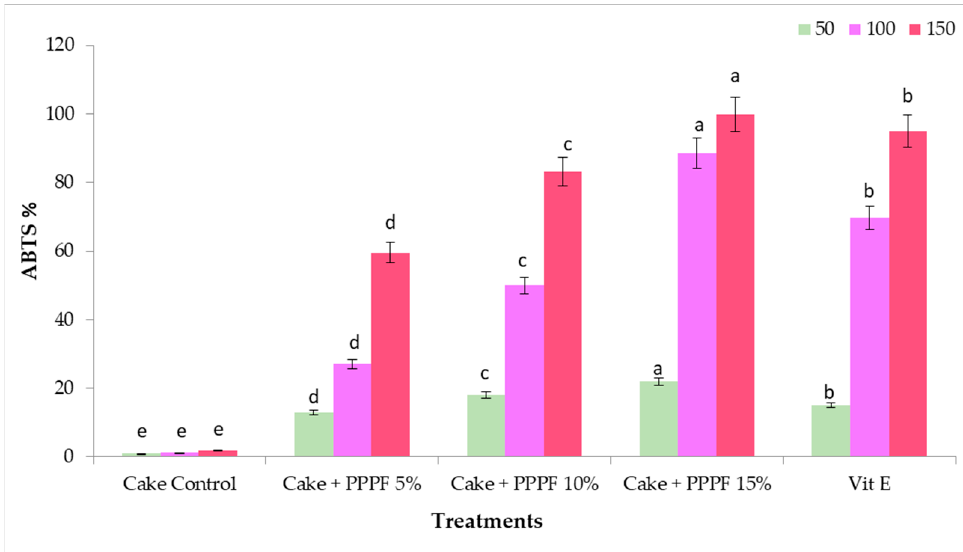
Figure 6. Antioxidants capacity % of cake treatments prepared by replacing flour with various levels of prickly pear peel flour (50, 100, and 150 µg/mL of PPPF) against ABTS. Each value represents the mean (±SD) of three different replications. Different letters on the same bar show a significant difference according to Duncan’s test at p ≤ 0.05.